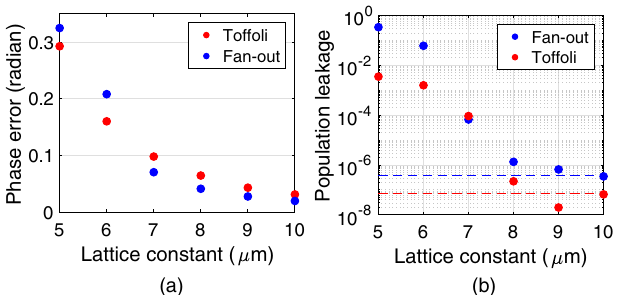
ffiffiffiffiffiffiffiffiffiffi C